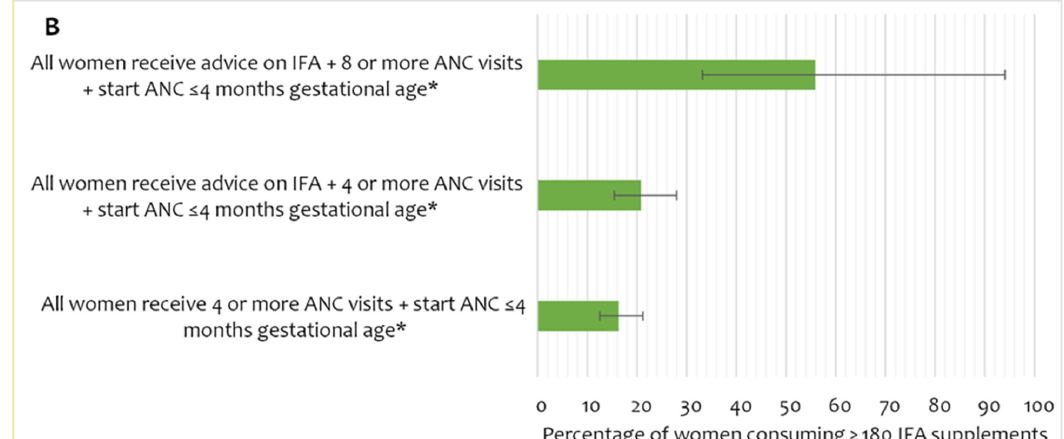
Figure 4. ( A ) User adherence-adjusted effective coverage of IFA supplementation (consuming ≥ 180 IFA) by the number of ANC and timing of first ANC, ( B ) scenario-based projections of user adherence-adjusted coverage of IFA assuming universal coverage of relevant antenatal interventions. * Adjusted for region/area, mother’s education, wealth, exposure to mass media, birth order, receiving free IFA, and receiving IFA only from ANC contracts. IFA—iron and folic acid, ANC—antenatal care.